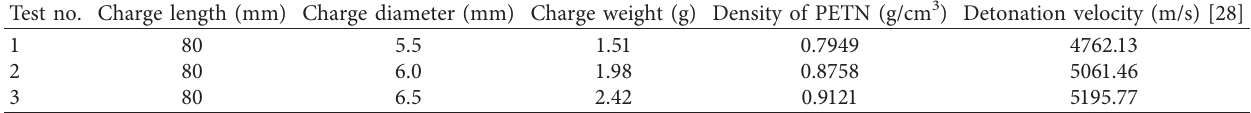
Table 2: Charge parameters.